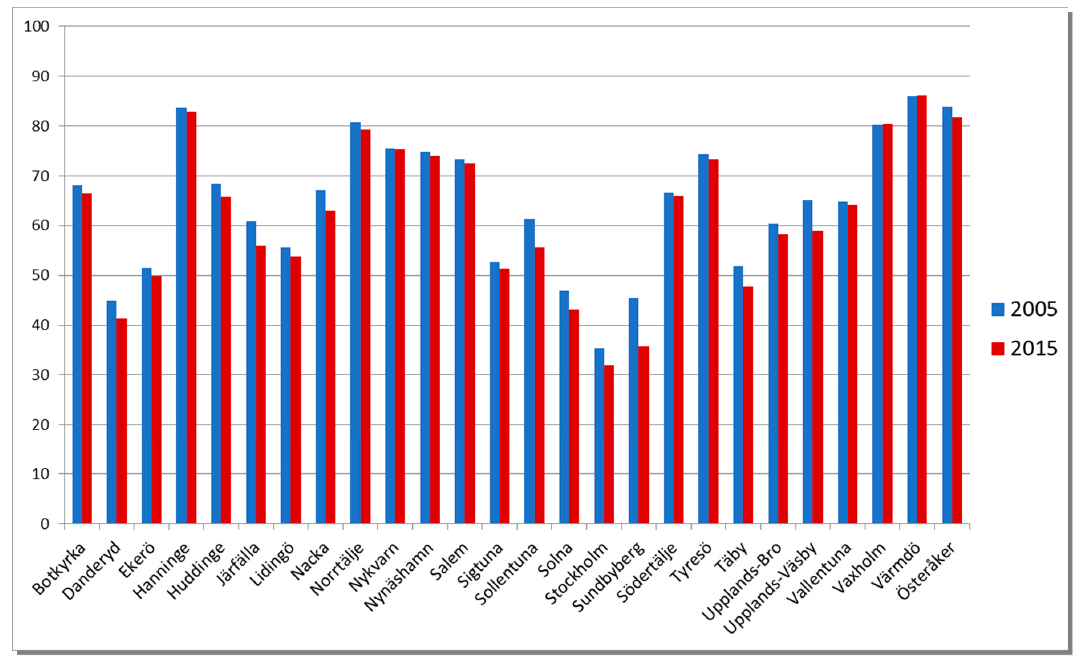
Figure 6. Change in green structure land area percentage per municipality in Stockholm County between 2005 and 2015.